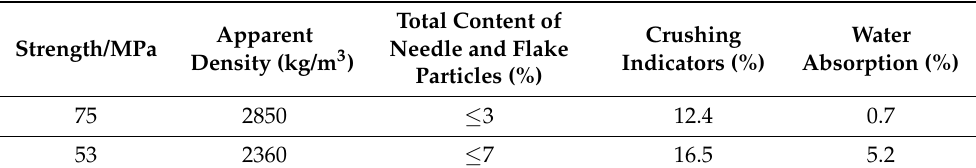
Table 3. Physical parameters of gravel.